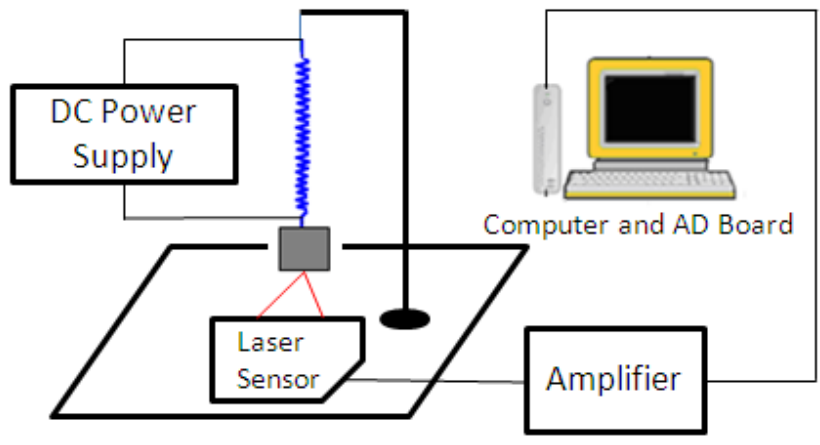
Figure 9. The deformation measuring system.